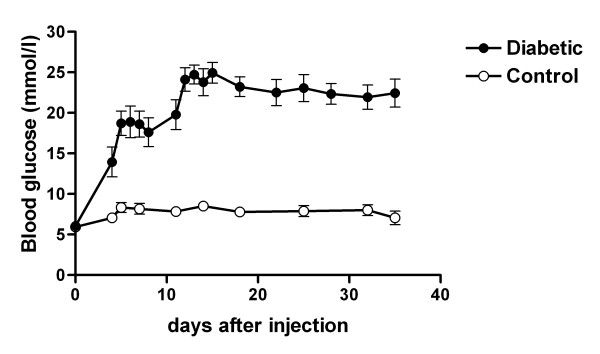
Blood glucose levels in control and diabetic mice. Mice were treated with streptozotocin (STZ) or citrate buffer on days 0 and 1. The onset of hyperglycemia occurred within one week after STZ injection. Mice were given low dosages of long acting insulin to maintain blood glucose at 19–25 mmol/l. Values are mean ± SEM. Control, n = 12; diabetic, n = 8.